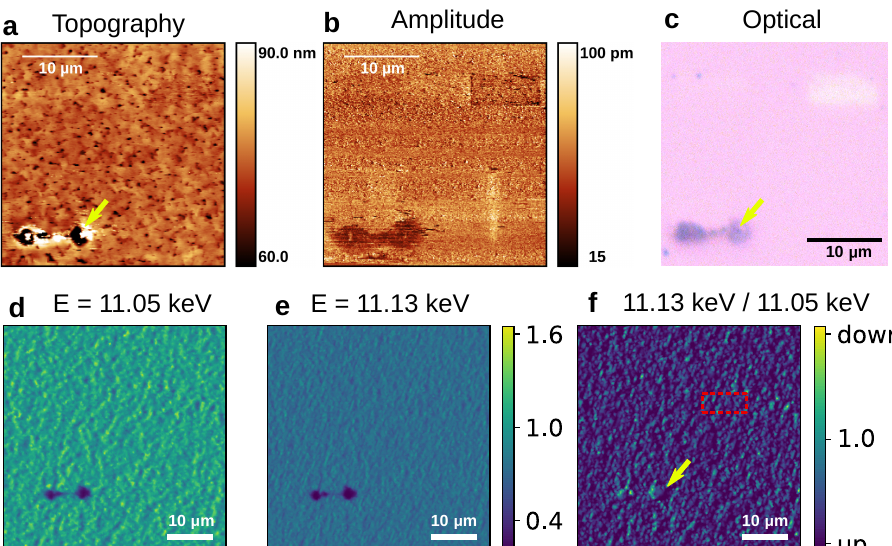
Figure 5. Comparison of PFM and scanning XRD microscopy. ( a ) shows the AFM topography ( b , c ) show the PFM amplitude and an optical microscope image in the same sample area; ( d , e ) show the scanning XRD intensities of the 444 Bragg reflection recorded with photon energies of E = 11.05 keV and E = 11.13 keV. Note that the intensities were normalized to yield an average of 1 in panel ( d ); ( f ) ratio of intensities shown in panels ( e ) divided by ( d ). A red dashed line marks the location where a written field can be seen in ( b , c ). A yellow arrow in ( a , c , f ) marks a defect induced by too high bias voltage while writing and used as a marker for the different